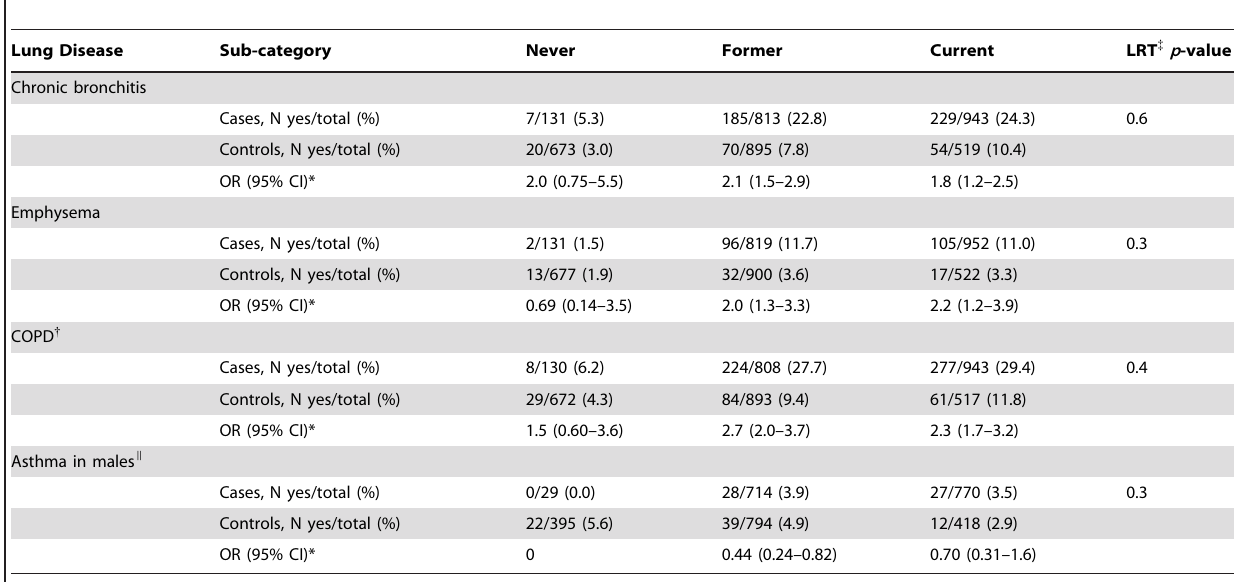
Table 3. Associations of lung cancer with lung disease diagnosed at least one year prior and lung cancer in the Environment And Genetics in Lung cancer Etiology case-control study, stratified by smoking